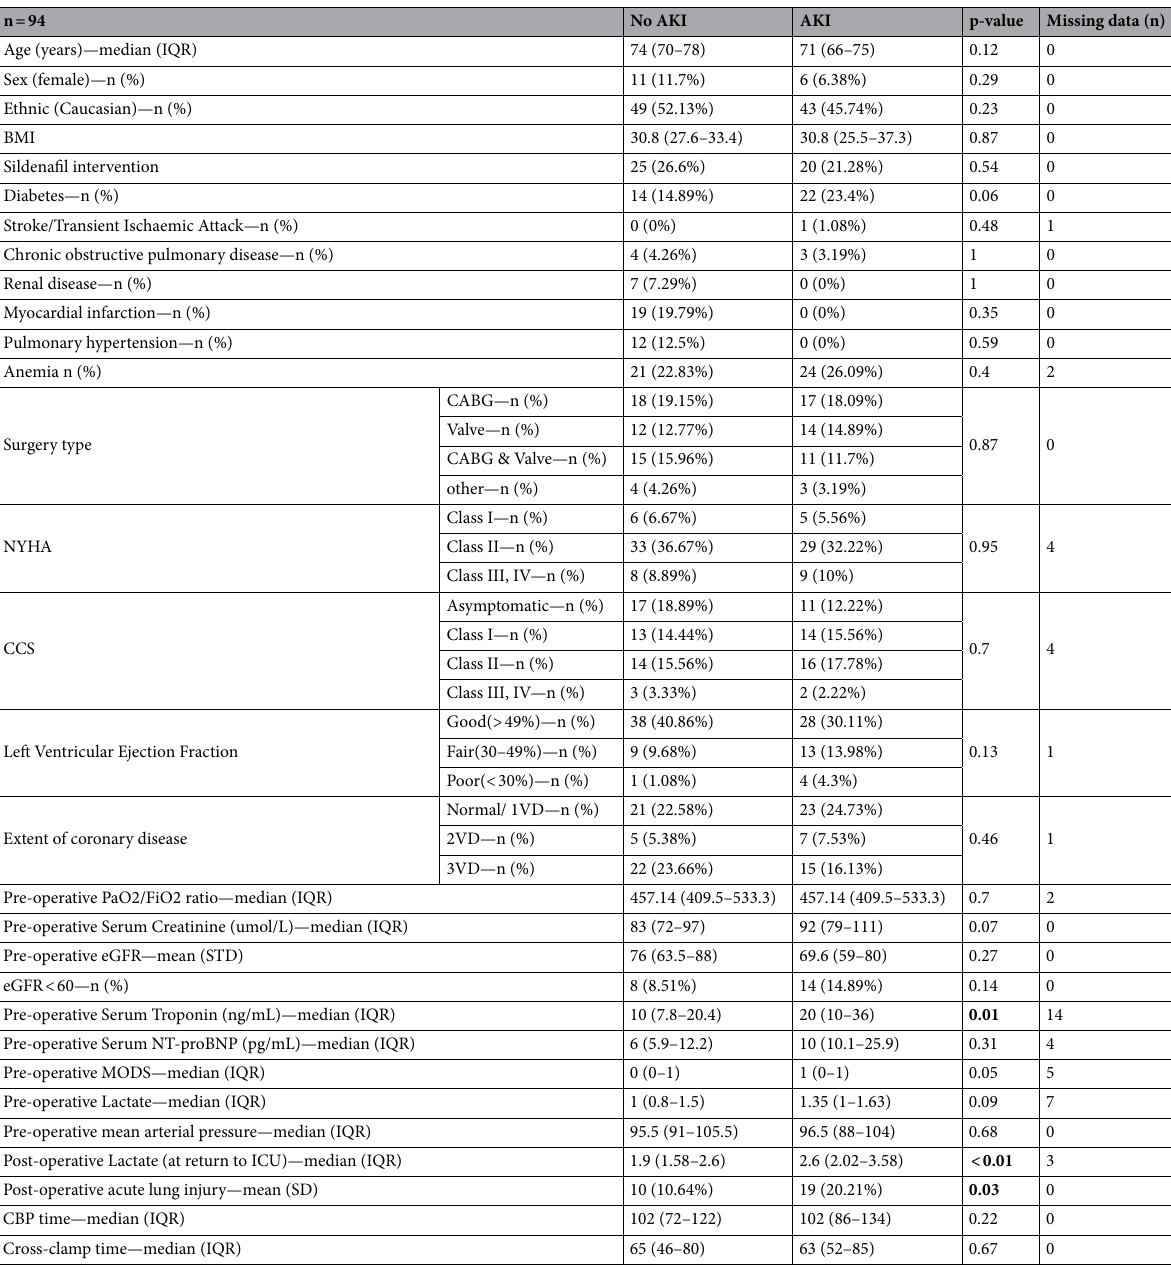
Table 1. Pre- and Postoperative characteristics in the analyzed cohort. ACE angiotensin-converting enzyme, AKI acute kidney injury, CABG coronary artery bypass grafting, CCS Canadian Cardiovascular Society, Hct Hematocrit, FiO2 fraction of inspired oxygen, KDIGO the kidney disease improving global outcomes, MODS multiple organ dysfunction score, NYHA New York Heart Association, PO2 partial pressure of oxygen, RBC red blood cells, VD vessel disease. (*) Tests between groups were conducted by exact test for categorical variables and ANOVA or non-parametric Kruskal–Wallis test for continuous variables. Data are presented as n (%) for categorical variables and mean (standard deviation, STD) or median (interquartile range, IQR) for continuous variables. Significant values are given in